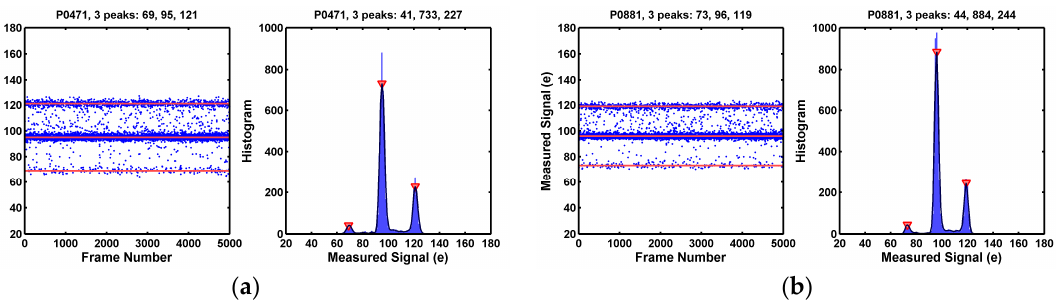
Figure 8. ( a , b ) Two example pixels showing 3 clearly identifiable histogram peaks with 2 asymmetric side peaks. These are believed to be the single RTN trap behaviors as well. But the probabilities of trap occupancy (PTO) during the first sampling and the second sampling of the CDS are not equal. The mechanism causing the asymmetry is discussed in Section 8.1.